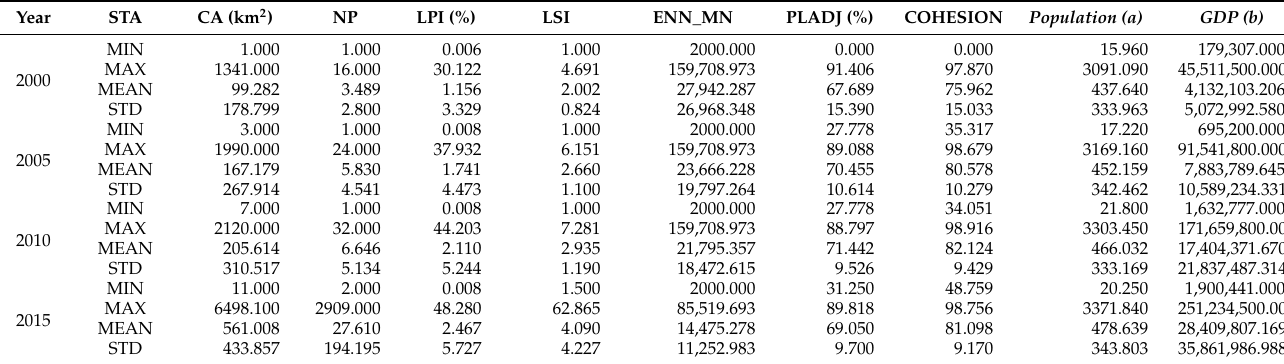
Table 2. Statistics of the metrics at the city